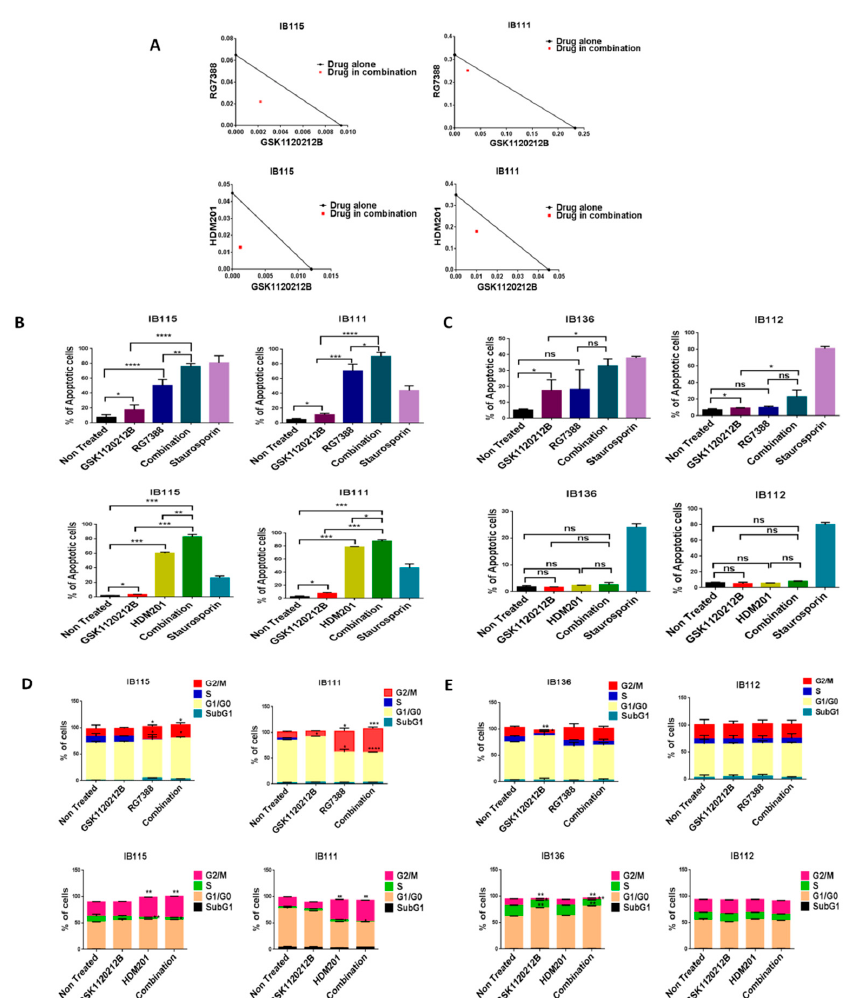
Figure 2. MDM2 antagonists synergize with a MEK inhibitor in p53 wild-type cells. ( A )